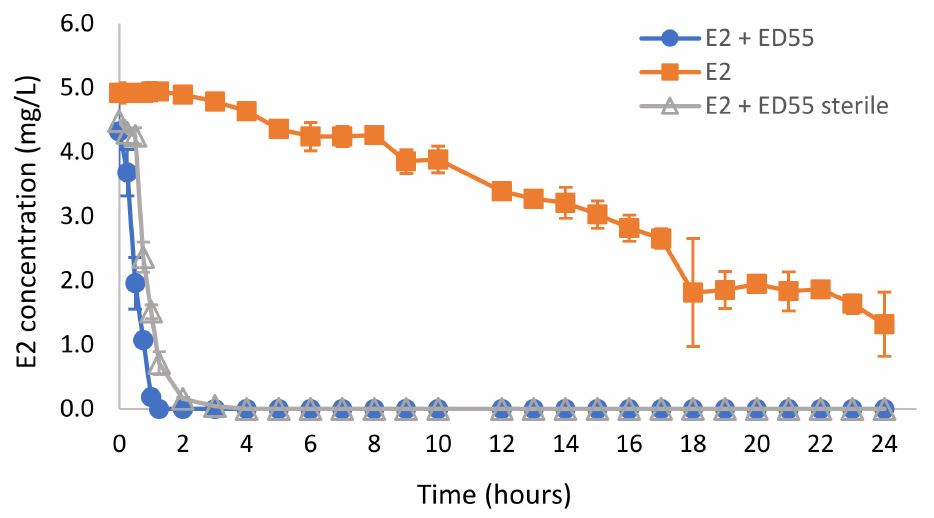
Figure 3. Removal of E2 in municipal wastewater: non-autoclaved wastewater without the addition of the bacterial strain ( (cid:4) ) and bioaugmented with Rhodococcus sp. ED55 ( • ); and autoclaved wastewater bioaugmented with Rhodococcus sp. ED55 ( ∆ ). Error bars represent the standard deviation achieved carrying out the experiment in